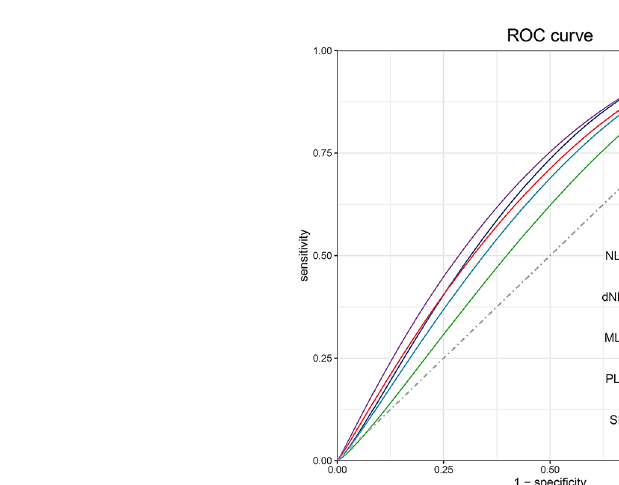
162 patients, 62 (38.3%) were in the low-risk group, 82 (50.6%) in the middle-risk group, and 18 (11.1%) in the high-risk group. The mPFS was the longest in the low-risk group at 12.1 months (95% CI: 8.009-16.124), followed by 7.3 months (95% CI: 6.201-8.466) for the